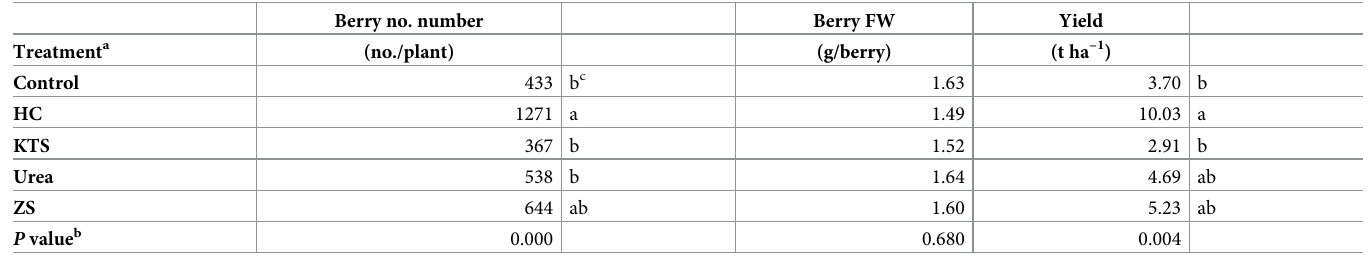
Table 1. Berry number, fresh weight (FW), and yield of ‘Emerald’ blueberry grown under inadequate chilling conditions as affected by hydrogen cyanamide (HC) and defoliants in the 2018–2019 season (Expt. 1). Berry no. number Berry FW Yield Treatment